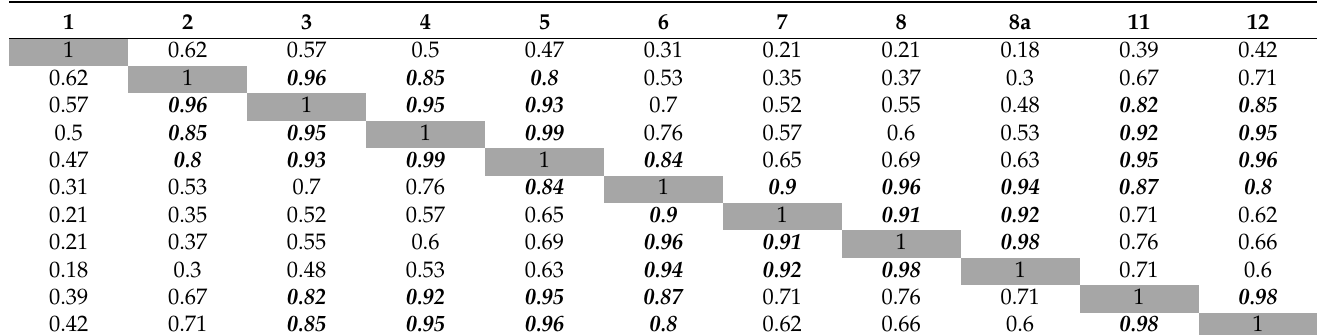
Table 1. Sentinel 2 MSI Band Pearson Correlation